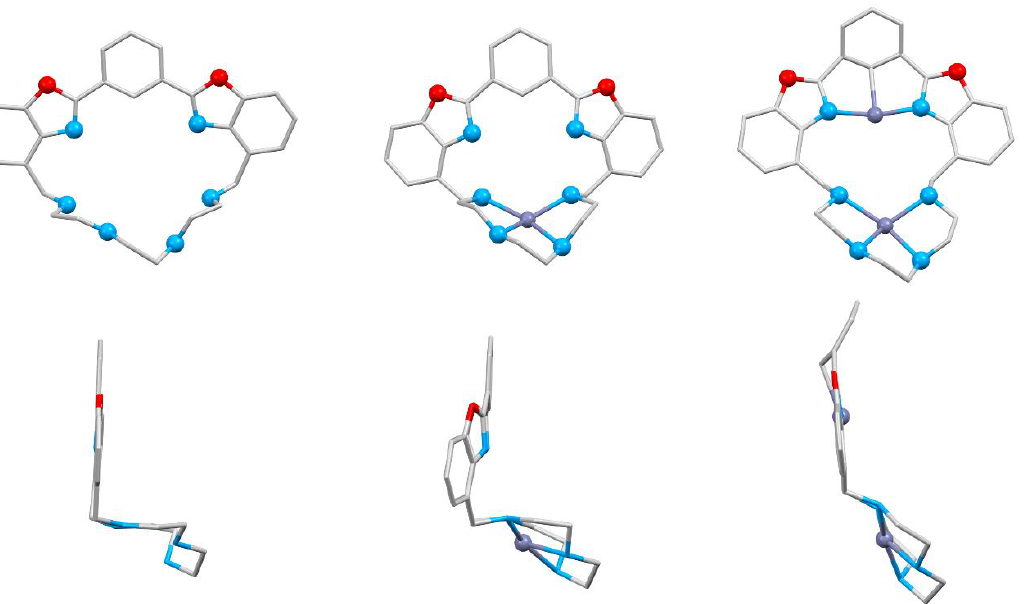
Figure 10. Front view (top) and side view (bottom) of the computed structures of (from left to right) L , [Zn L ] 2+ and [Zn 2 L ] 4+ . Hydrogen atoms are omitted for the sake of L , [Zn L ] 2+ and [Zn 2 L ] 4+ . Hydrogen atoms are omitted for the sake of clarity.